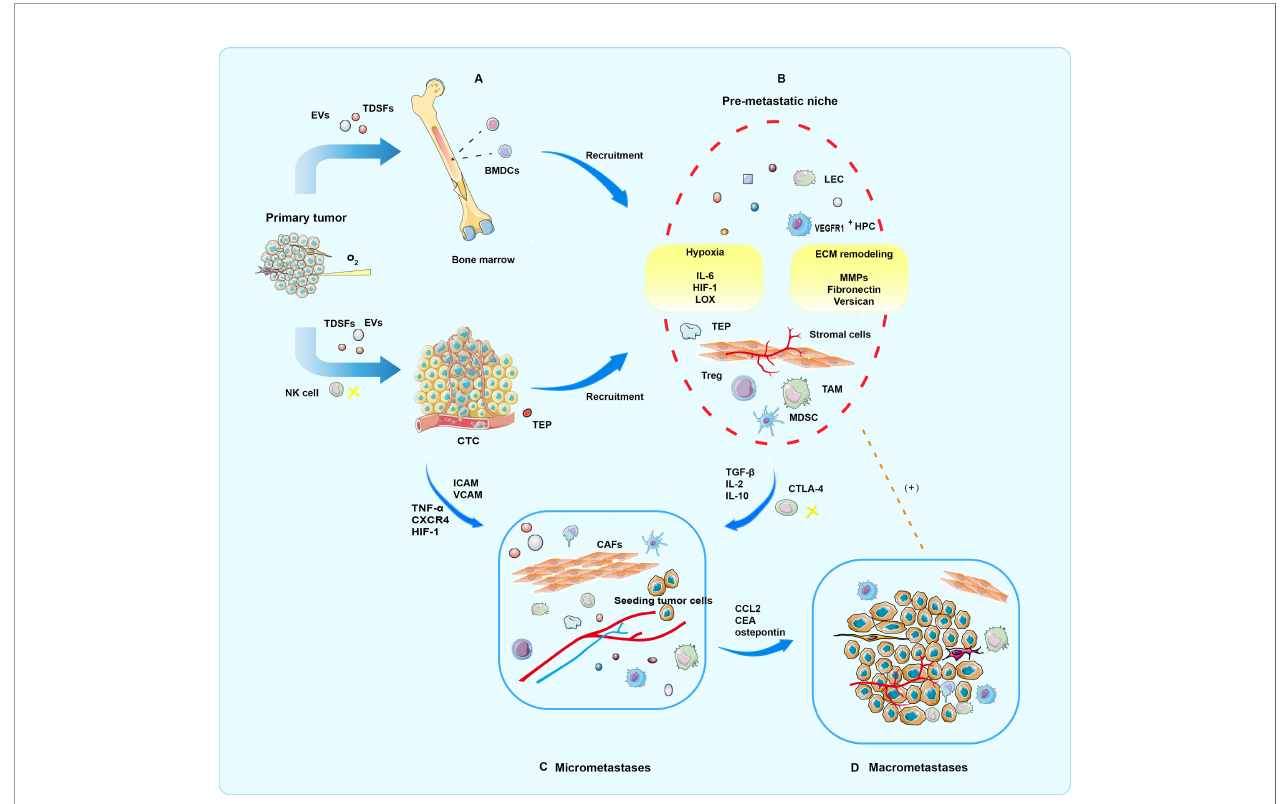
FIGURE 2 | Four periods of PMN formation. (A) In the priming phase, produced by primary tumor cells, TDSFs, EVs, and other molecular components trigger an immature PMN formation in the secondary organ site or the same organ outside the primary tumor. (B) In the licensing phase, BMDC, regulatory, and suppressive immune cells involved in ECM remodeling are mobilized and recruited into the secondary sites. Finally, a mature PMN prepared well for potential seeding and colonization of CTCs. In addition, hypoxia is a critical condition for progress. (C) In the initiation phase, partial CTCs arrive and survive at the fertile PMN, where tumor cell seeding, colonization, and outgrowth occur, eventually resulting in micrometastases. (D) In the progression phase, PMNs attract more tumor cells to colonize. Moreover, mutual promotion of tumor cells and PMN is locked in a vicious circle, which culminates in